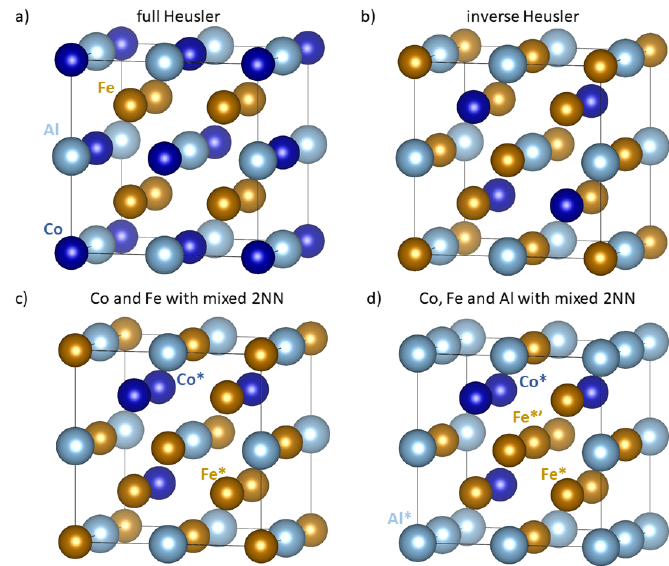
Figure 1. Schematic visualizations of 16-atom supercells of Fe 2 AlCo polymorphs used in our quantum-mechanical calculations (some atoms are shown with their periodic images). ( a ) Full Heusler structure. ( b ) Inverse Heusler structure. ( c ) Specific distribution of Co (and Fe) atoms regarding the atoms in the 2NN shell (see the text). ( d ) Special arrangement of atoms of all three chemical species. Selected atoms discussed in the text are marked by a star and/or a prime